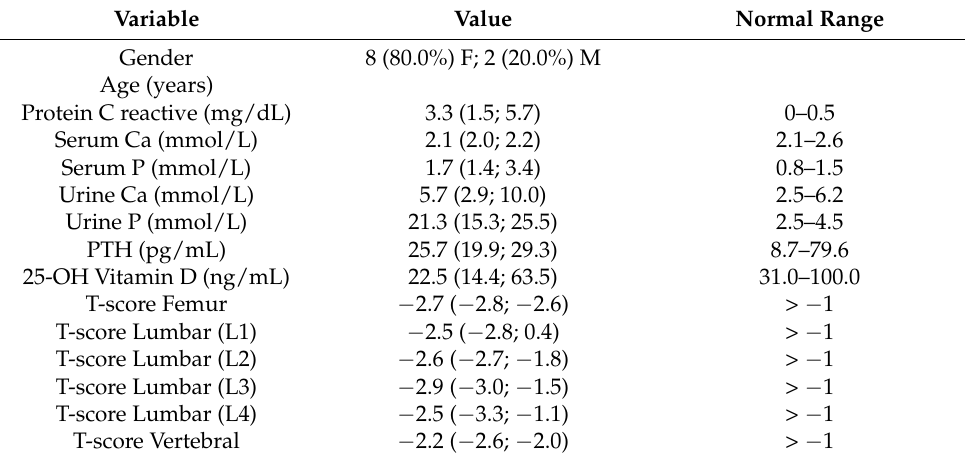
Table 1. Demographics and clinical parameters of the